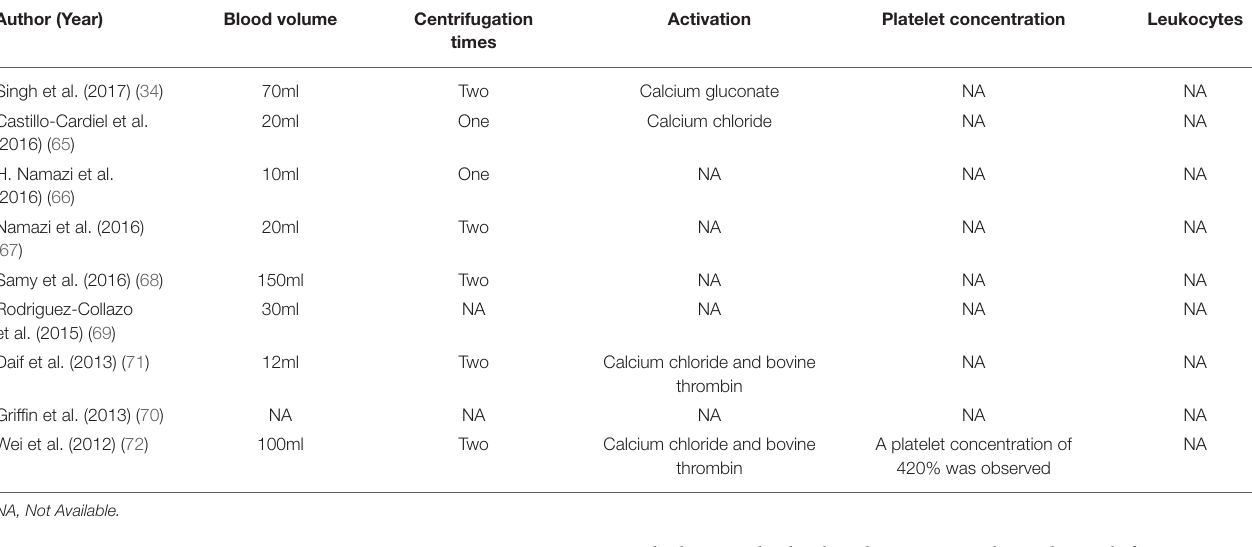
TABLE 5 | The PRP preparation in clinical studies.